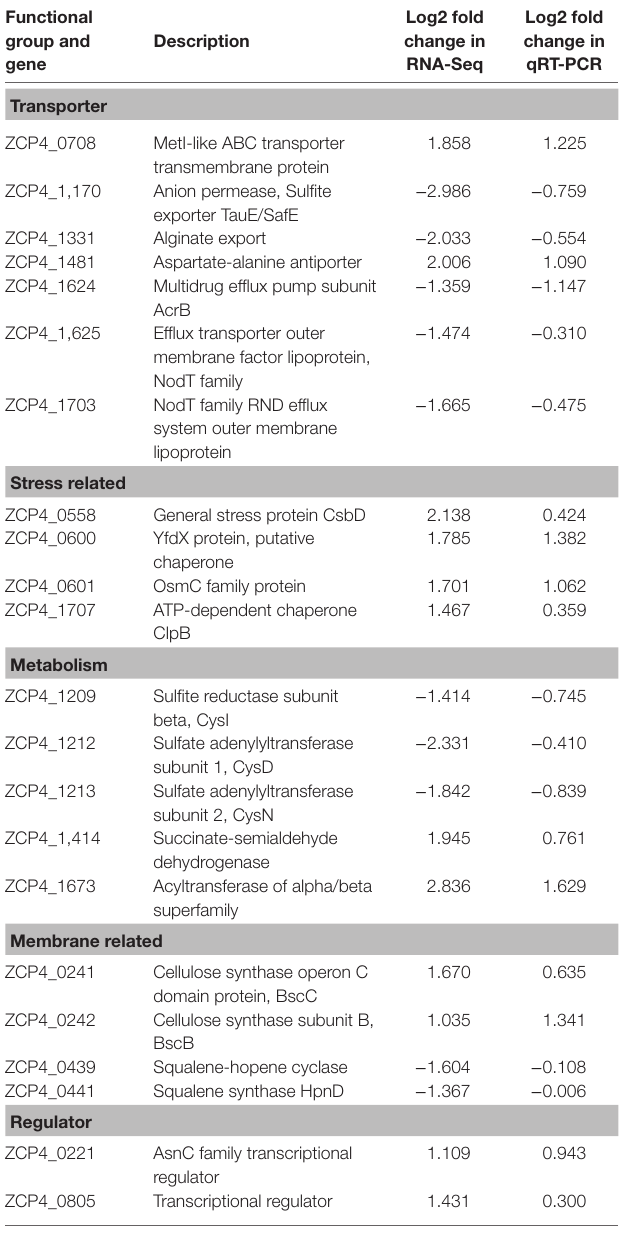
TABLE 2 | The differentially expressed genes used for qRT-PCR verification. Functional group and